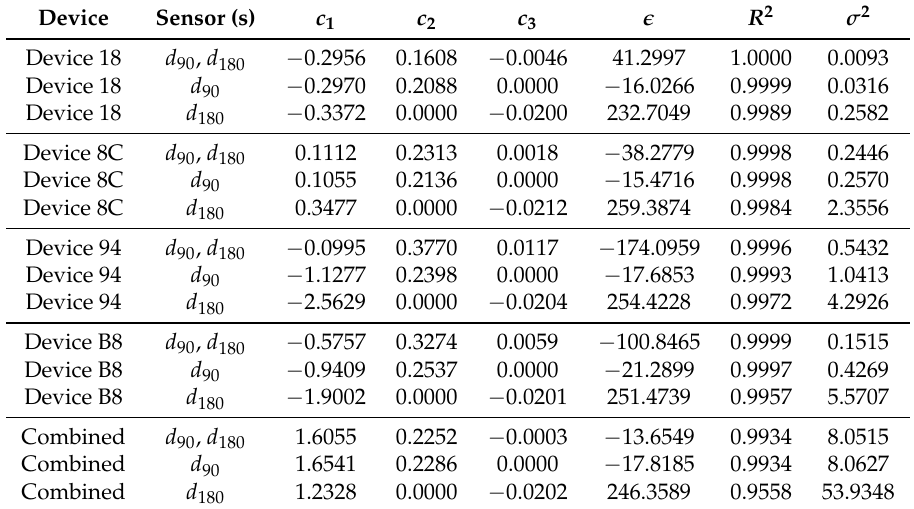
Table 3. Individual and combined model parameters, R 2 , and residual variance ( σ 2 ) for using the 90- and 180-degree sensors, only the 90 degree, and only the 180 degree sensor respectively. The units of c 1 , c 2 and c 3 are NTU/lux. The unit of (cid:101) and σ 2 are NTU and NTU 2